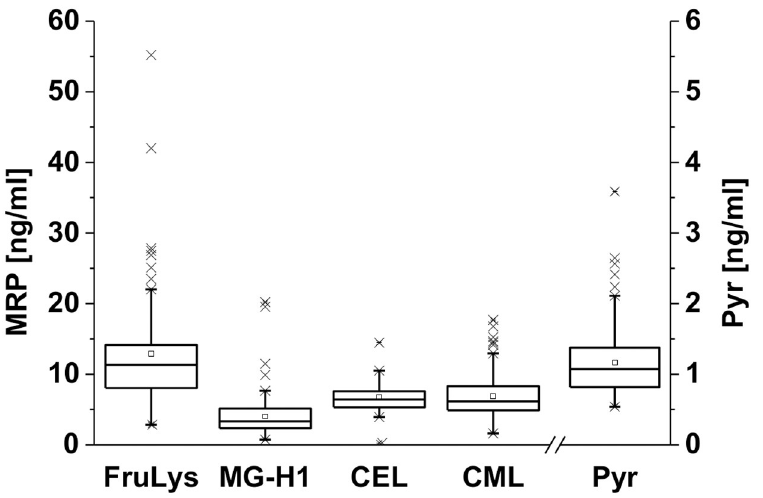
Fig 2. Concentrations of free MRPs in pre-concentrated saliva samples from 33 subjects on three consecutive days. The square indicates the mean, the line indicates the median. CEL was detected in 26/99 samples; presented data refer to samples with a CEL peak ratio S/N >